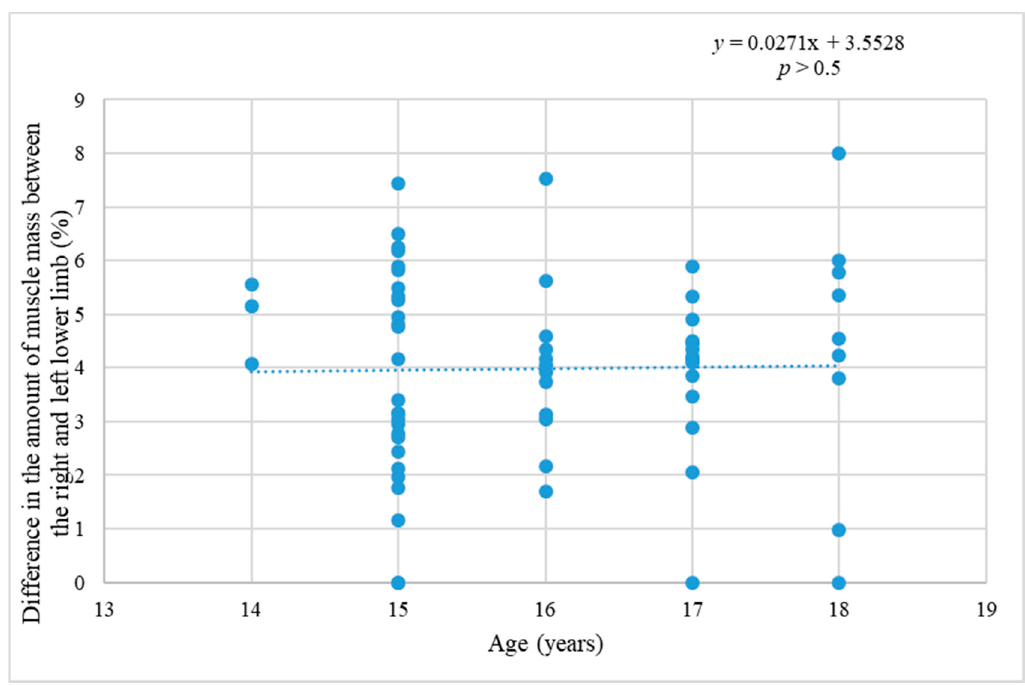
Figure 5. The relation of % difference in the amount of muscle mass (MM) in the individual legs and age.